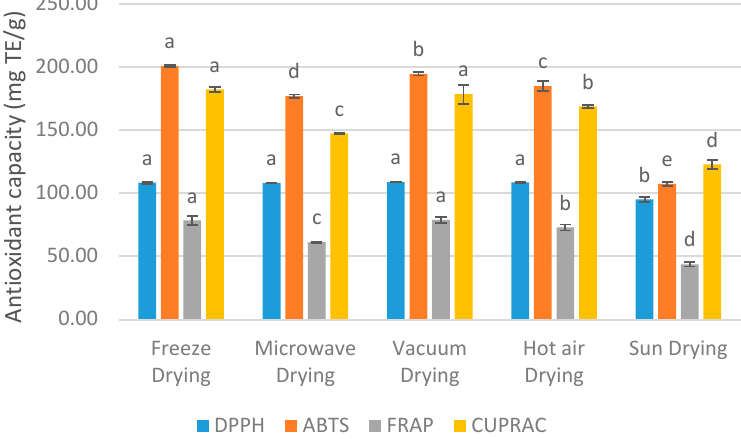
Figure 1. Effect of different drying methods on phytochemical properties from Tuckeroo fruit. Data are means ± standard deviations ( n = 3). Data of the bar for each category not sharing similar letters are significantly different at p < 0.05.